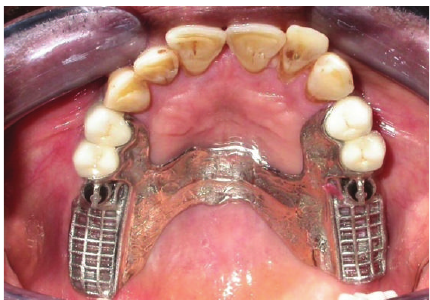
Figure 6: Framework trial in the patient’s mouth.